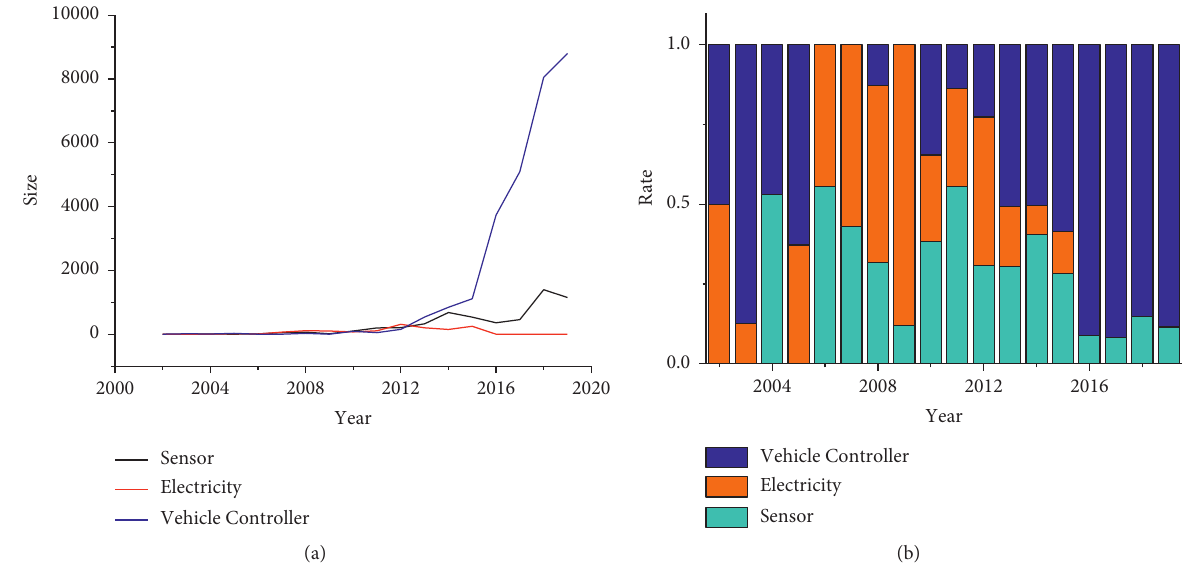
Figure 10: The trend of subdivided topics of “Hardware” in patents: (a) amount; (b) relative proportion.